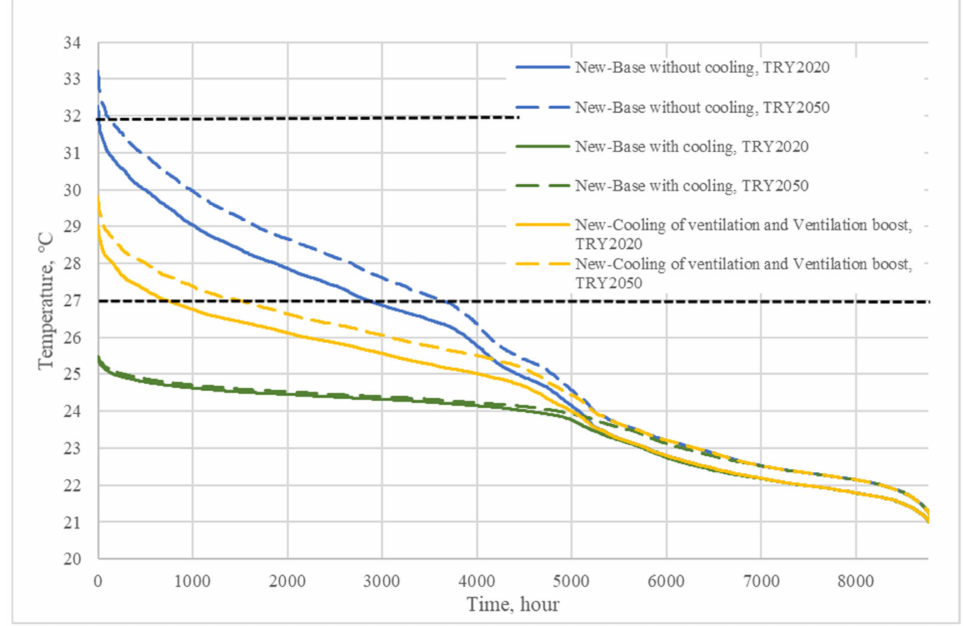
Figure 9. The annual hourly indoor air temperature profile of the warmest bedroom, base cases, new and old building, current and future climate. (The temperature levels of 27 ◦ C and 32 ◦ C are shown as black dashed lines.